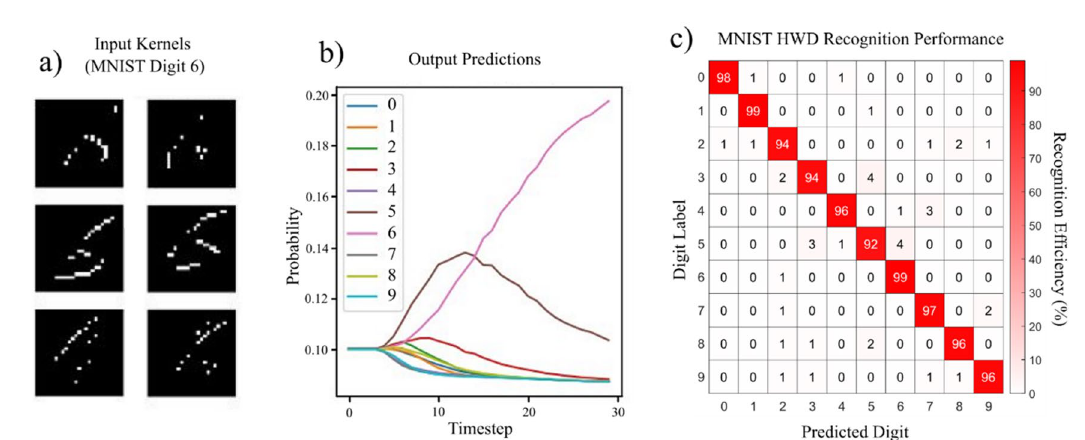
Figure 6. MNIST handwritten-digit classification with the hardware-software SNN. Six input feature maps, previously produced by the spiking VCSEL neuron (a) are introduced to the software implemented SNN and the resulting classification probability is plotted over multiple training cycles (b) . Results for an MNIST ‘Digit 6’ are plotted in (a,b) . A confusion matrix shows the task performance for each class of digit across the 5000 MNIST HWD images tested. The SNN produces an overall average performance of